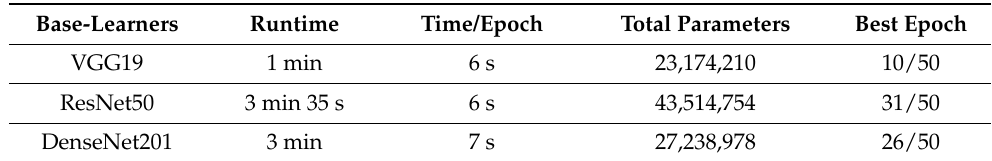
Table 5. Description of the Runtime, Time by epoch, Total parameters, and Best-epoch of the Base- Learners for SARS-CoV-2 CT-scan dataset [42].